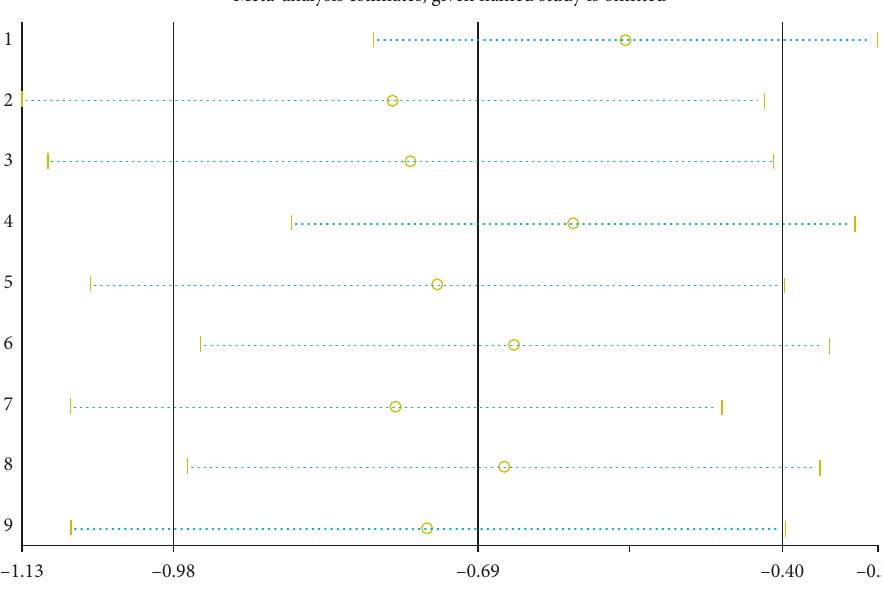
Figure 4: Sensitivity analysis of the